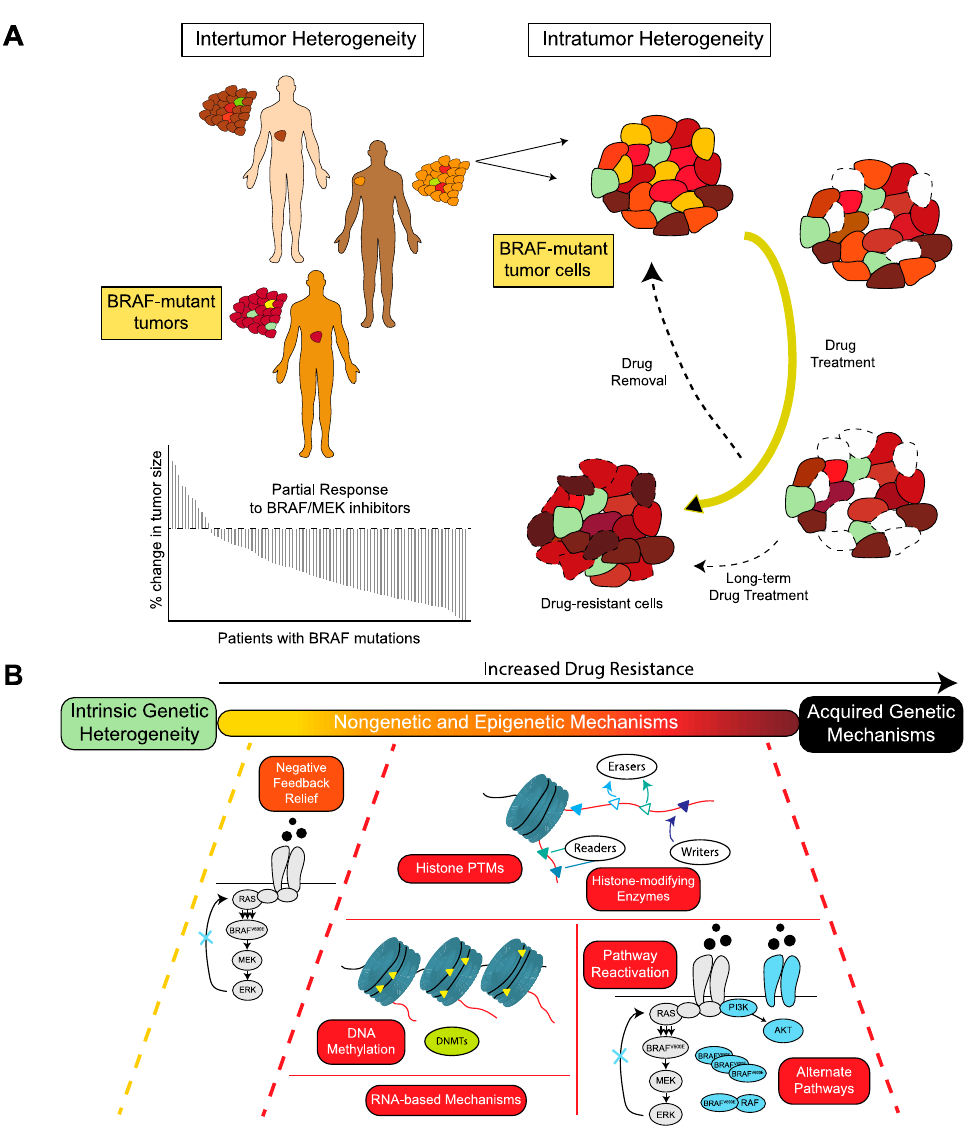
Figure 1. Dynamic mechanisms of inter- and intratumor heterogeneity. ( A ) Intertumor heterogeneity in patients with BRAF-mutant tumors results in a partial response to BRAF and MEK inhibitor therapy. Intratumor heterogeneity in BRAF-mutant tumors comprises of cells at distinct transcriptional cell states due to genetic (green), non-genetic (e.g. pathway rewiring) and epigenetic mechanisms (gradient from yellow to brown). A cell’s BRAF or MAPK dependency can determine its ability to tolerate or adapt to BRAF or MAPK inhibitor therapies. A cell with higher BRAF dependency is more sensitive to short-term BRAF inhibitor therapy (dashed outline), whereas a cell with lower BRAF dependency can better tolerate the drug over time by relying on non-genetic and epigenetic mechanisms. Long-term drug treatment can result in a stable, drug-resistant phenotype, whereas adaptive drug resistance is reversible. ( B ) Upon drug treatment, drug-tolerant cells can employ non-genetic (relief of MAPK negative feedback, MAPK pathway reactivation, and alternate pathways, such as the PI3K pathway) and epigenetic mechanisms (DNA methylation, histone modifications, histone-modifying enzymes, and RNA-based mechanisms) to escape drug effect. Over time, these drug-tolerant, drug-adaptive mechanisms can ensure cells survive long enough to acquire advantageous mutations that lower the cell’s BRAF dependency and lead to long-term resistance. Genetic mechanisms of resistance comprise of mutations in the MAPK pathway, including NRAS, KRAS and MEK1 mutations, NF1 loss of function, as well as mutations in the AKT/PI3K